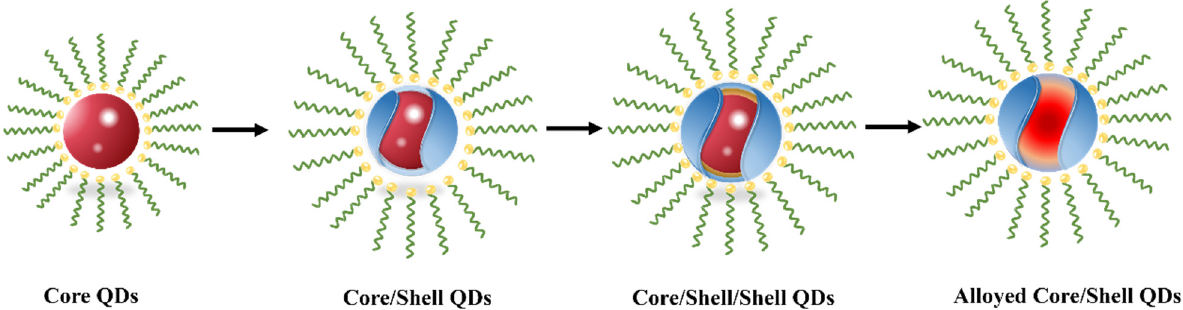
Figure 2. Schematic diagram of the development of InP QDs.